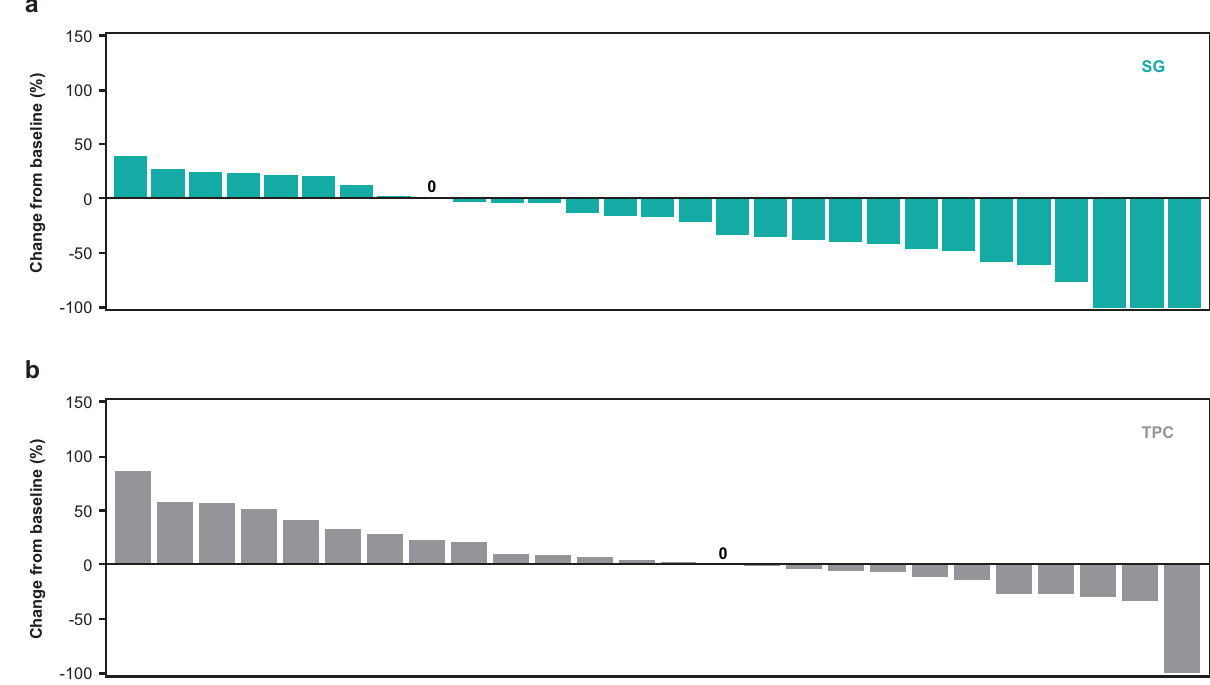
Fig. 3 Best percent change in lesion size from baseline in the second-line subgroup. Waterfall plot showing best percent change from baseline in the sum of the diameters of target lesions in second-line patients treated with SG ( a ) or TPC ( b ). Assessed by independent central review in the brain metastasis-negative population. Second-line patients were de fi ned as those who received 1 line of therapy in the metastatic setting and recurred ≤ 12 months after (neo)adjuvant chemotherapy, prior to study enrollment. SG sacituzumab govitecan, TPC treatment of physician ’ s